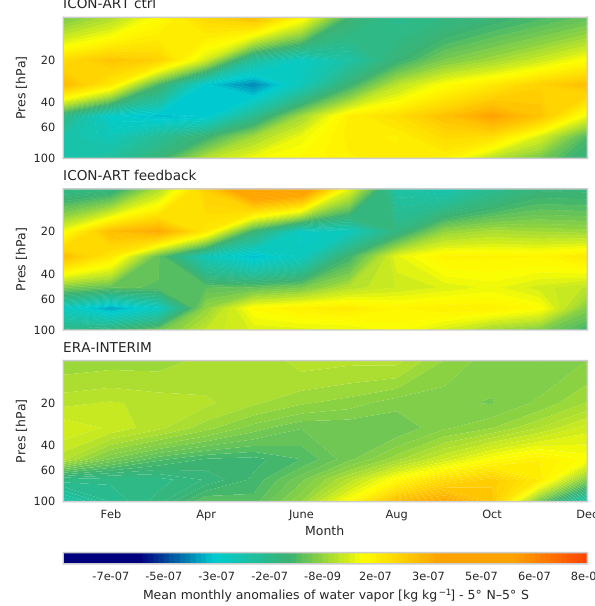
Figure B7. Tropical (5 ◦ N–5 ◦ S) water vapour anomalies as monthly mean deviations from the annual mean, averaged from 1980 to 2009, as a function of months and